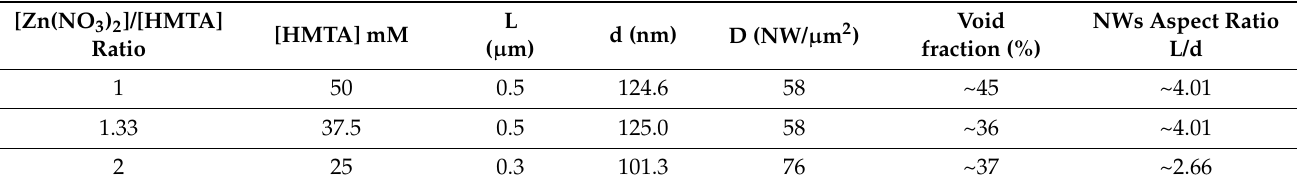
Table 4. Summary of the length, diameter, apparent density, and void fraction of ZnO NWs as a function of the [Zn(NO 3 ) 2 ]/[HMTA] ratio. The concentration of the Zn(NO 3 ) 2 solution is 50 mM, and the growing time is fixed at 6 h (temperature at 90 ◦